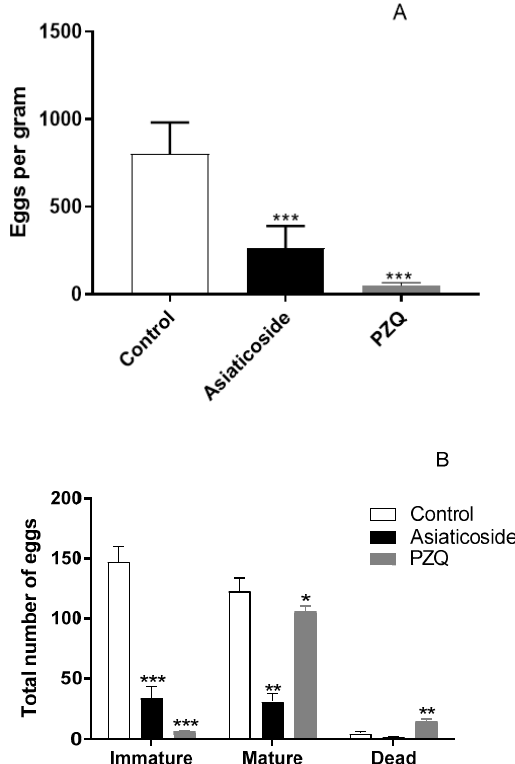
Figure 7. Effects on stool egg load ( A ) and on egg development stages (oogram) ( B ) of single doses of asiaticoside (400 mg/kg, p.o.) or PZQ (400 mg/kg, p.o.) administered to mice harboring a 49-day-old adult S. mansoni infection. Bars (mean ± SD) represent data from five individual mice that were infected and treated with asiaticoside, PZQ or vehicle (control). *** p < 0.001, ** p < 0.01, and * p < 0.05, compared with group treated with vehicle (control), using the Dunnett’s multiple-comparison